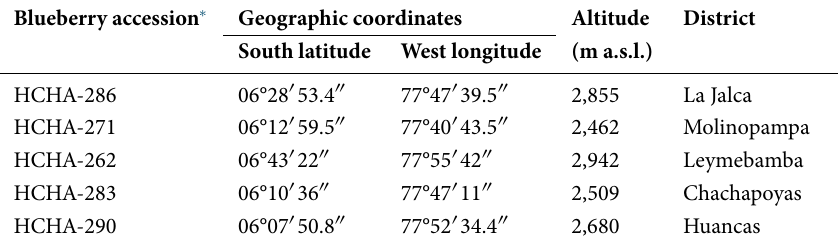
Table 1 Geographic locations of five accessions of wild